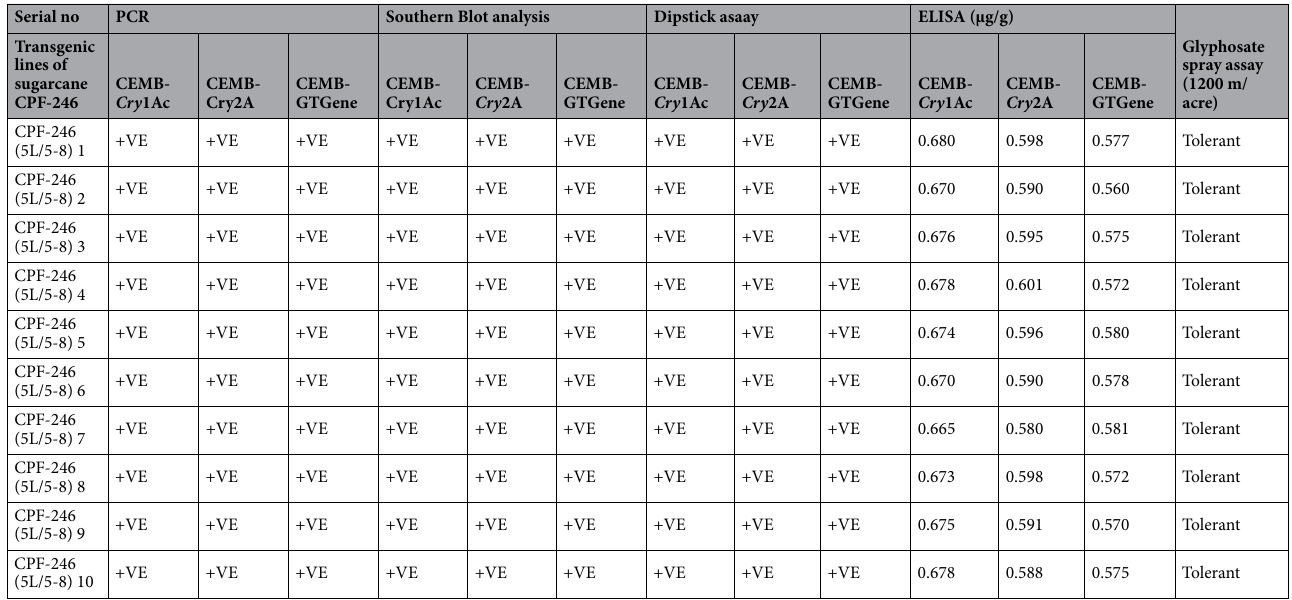
Table 6. Molecular analysis of CPF-246 (L5/5-8) transgenic sugarcane plants from V 2